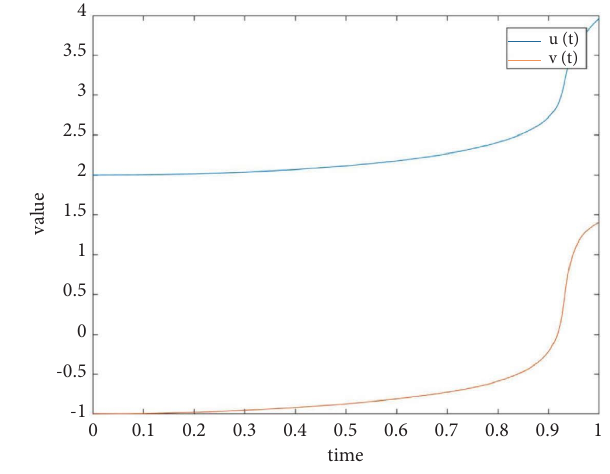
Figure 1: Te solution of Example